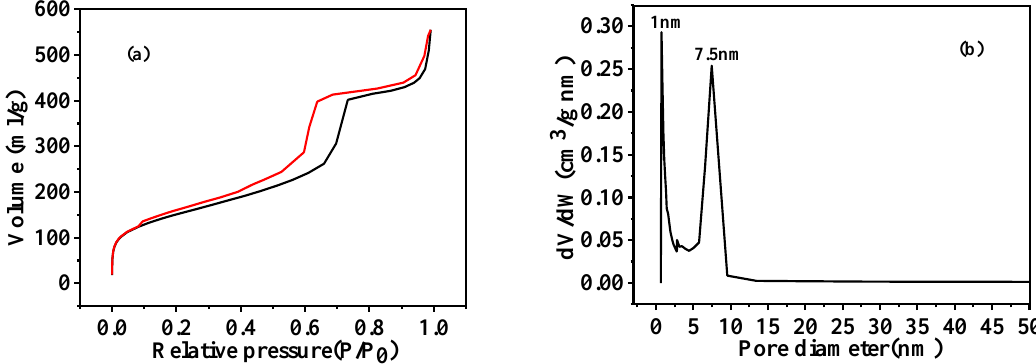
Figure 8. N 2 adsorption–desorption isotherm ( a ) and pore size distribution curves ( b ) of HGCS prepared at 900 °C for 3 h with 1.0 wt % Fe catalyst.